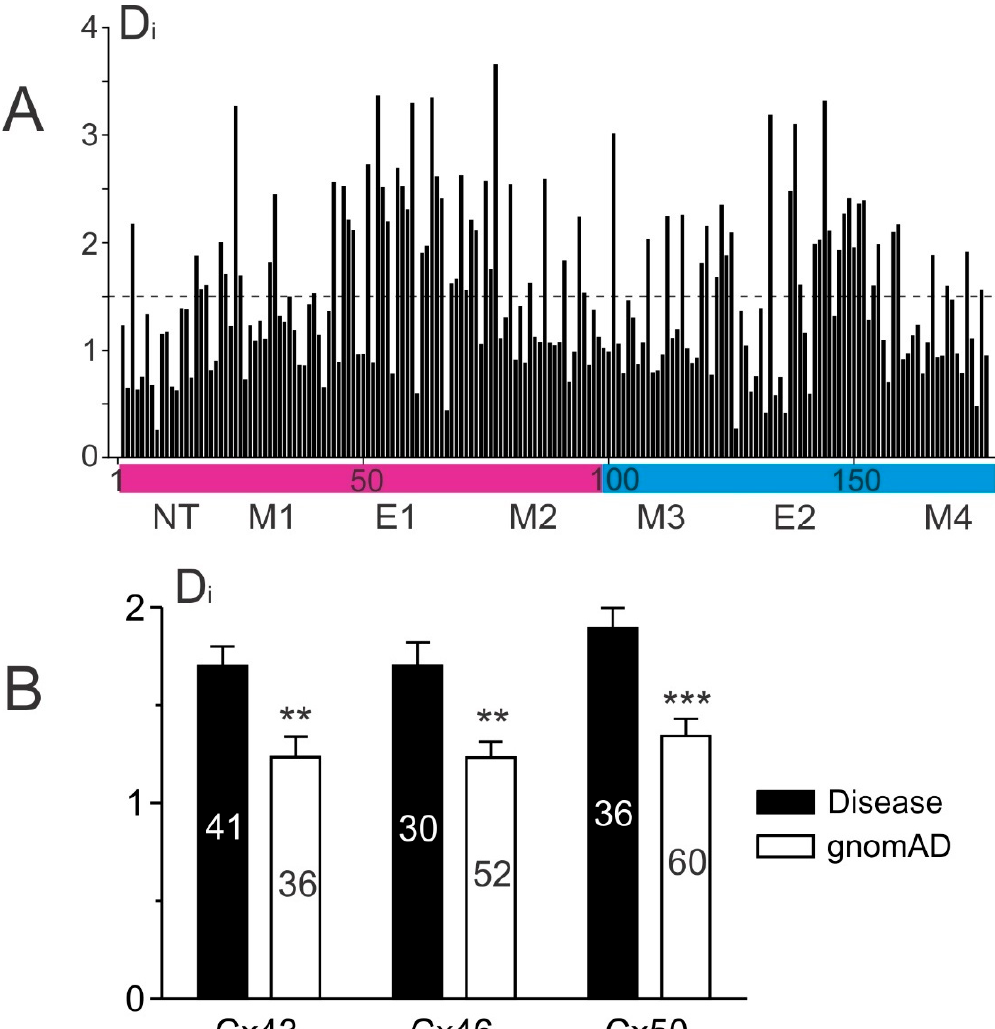
Figure 8. Disease-linked missense variants are enriched on highly conserved positions in connexins. ( A ) Over 9000 connexins from different species are aligned to sheep Cx46 on the structure resolved domains. The conservation of each residue position was plotted as a bar graph of the calculated Kullback–Leibler relative entropy (Di values). The dashed line indicates the average Di of these positions. Residues that fall into the magenta-colored bar are the pore domains including NT, M1, E1, and M2. Residues that fall into the blue-colored bar are the non-pore domains, including M3, E2, and M4 domains. ( B ) The averaged Di values of disease-linked variant positions are significantly higher than those corresponding to the gnomAD-linked variants for each of the selected connexin (mean ± SEM, ** p < 0.01 and *** p < 0.001). The total number of positions for each case are shown on the